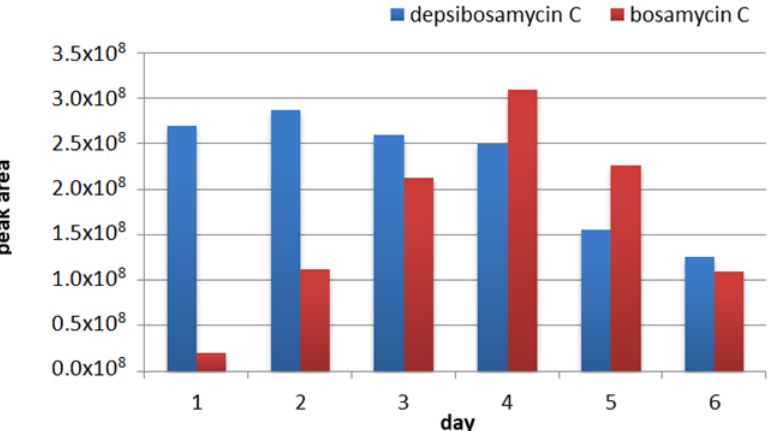
Figure 5. Depsibosamycin C and bosamycin C production in S. aurantiacus LU19075 over the course of 6 days.